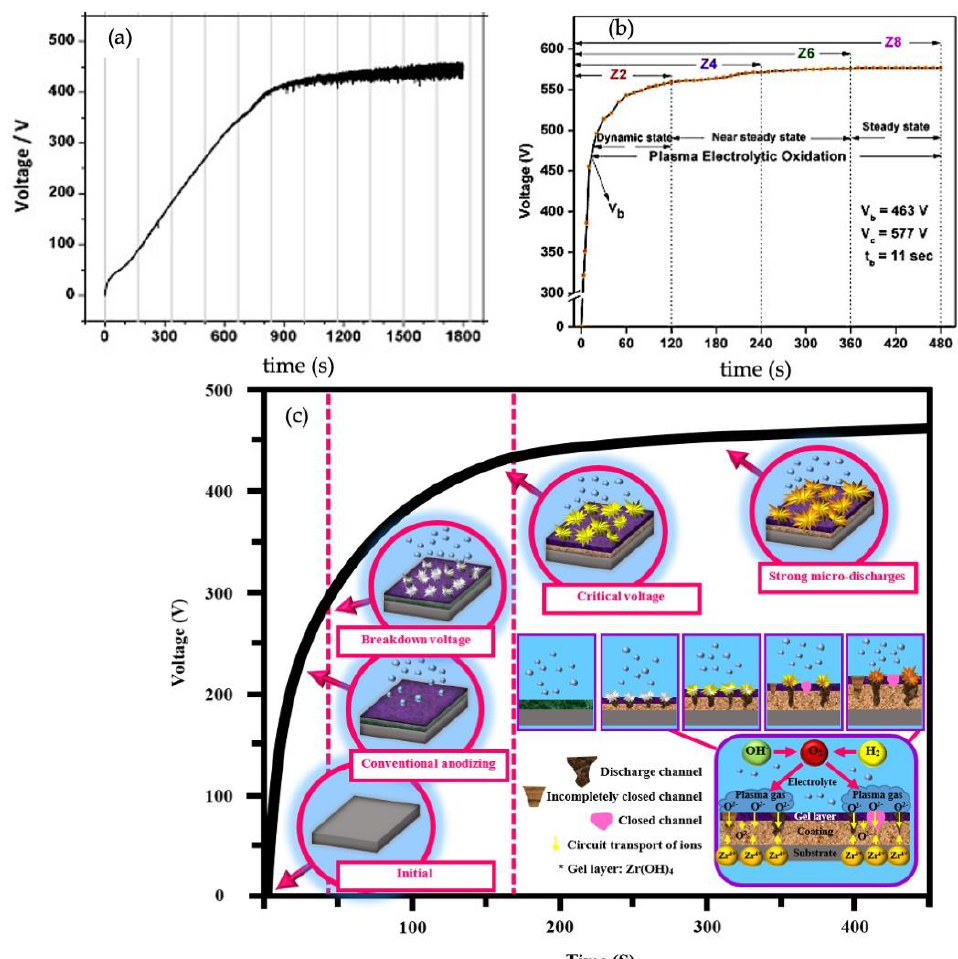
Figure 2. ( a ) Anodization curves of Zr at 5 °C obtained at 20 mA/cm 2 in 0.5 mol/L H 3 PO 4 [11] (repro- duced with permission number: 5034230474964, Elsevier); ( b ) chronopotentiograph for the PEO